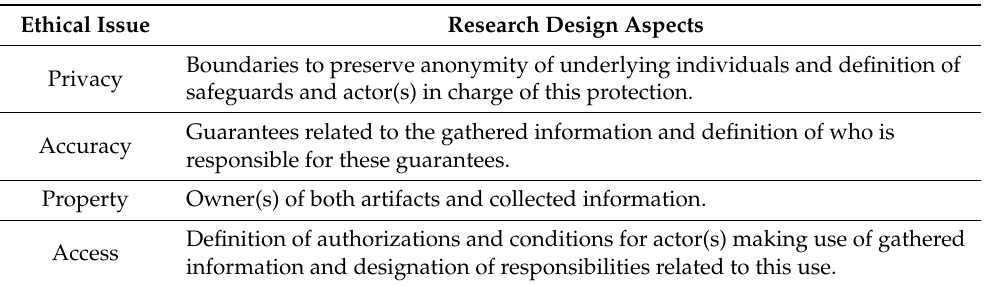
Table 1. Ethical issues for research in